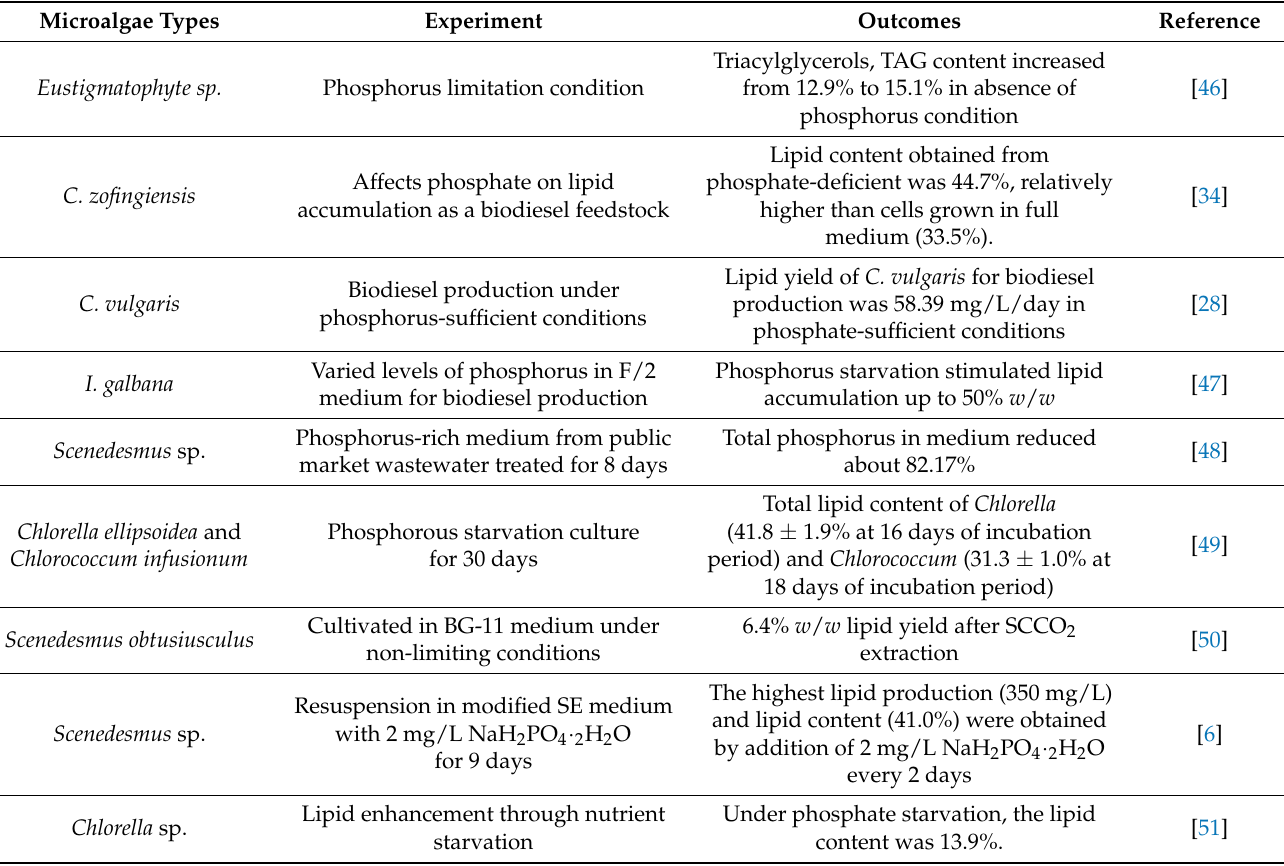
Table 3. Microalgae cultivation in relation to phosphorus